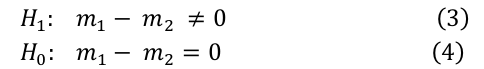
Table 1. FDR value of feature points using convex hull